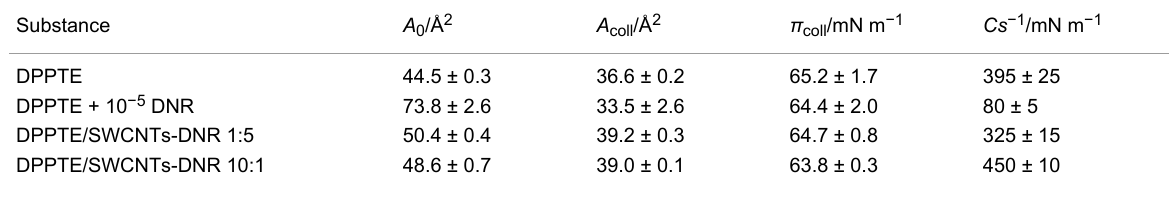
Table 1: Characteristic parameters of DPPTE Langmuir monolayers in the presence of free daunorubicin and daunorubicin attached to carbon nano- tubes. Substance